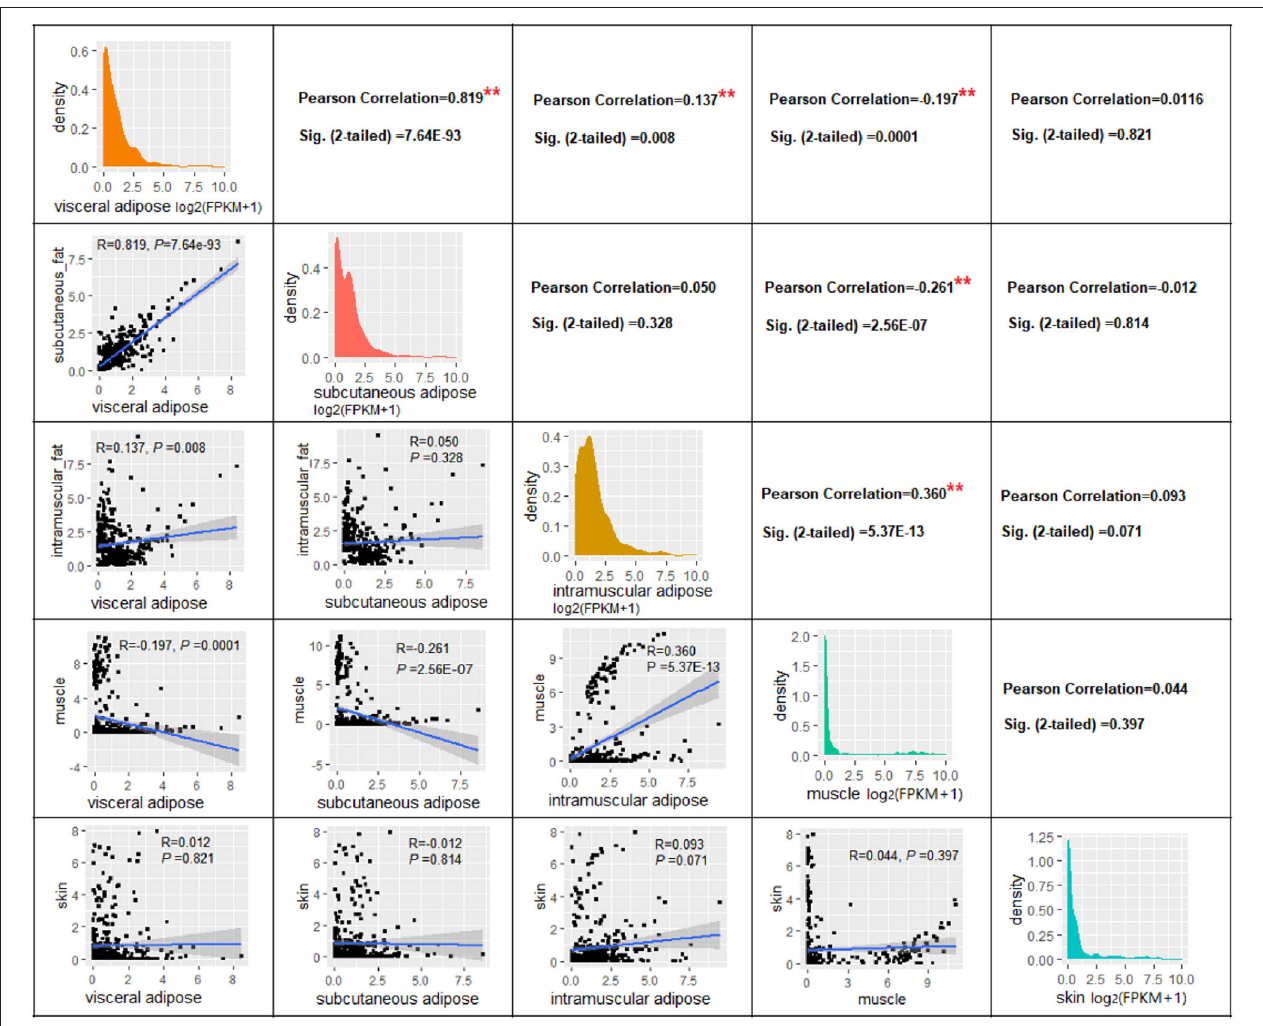
FIGURE 5 | The correlation of expression level of genes in four tissues. ** P < 0.01.